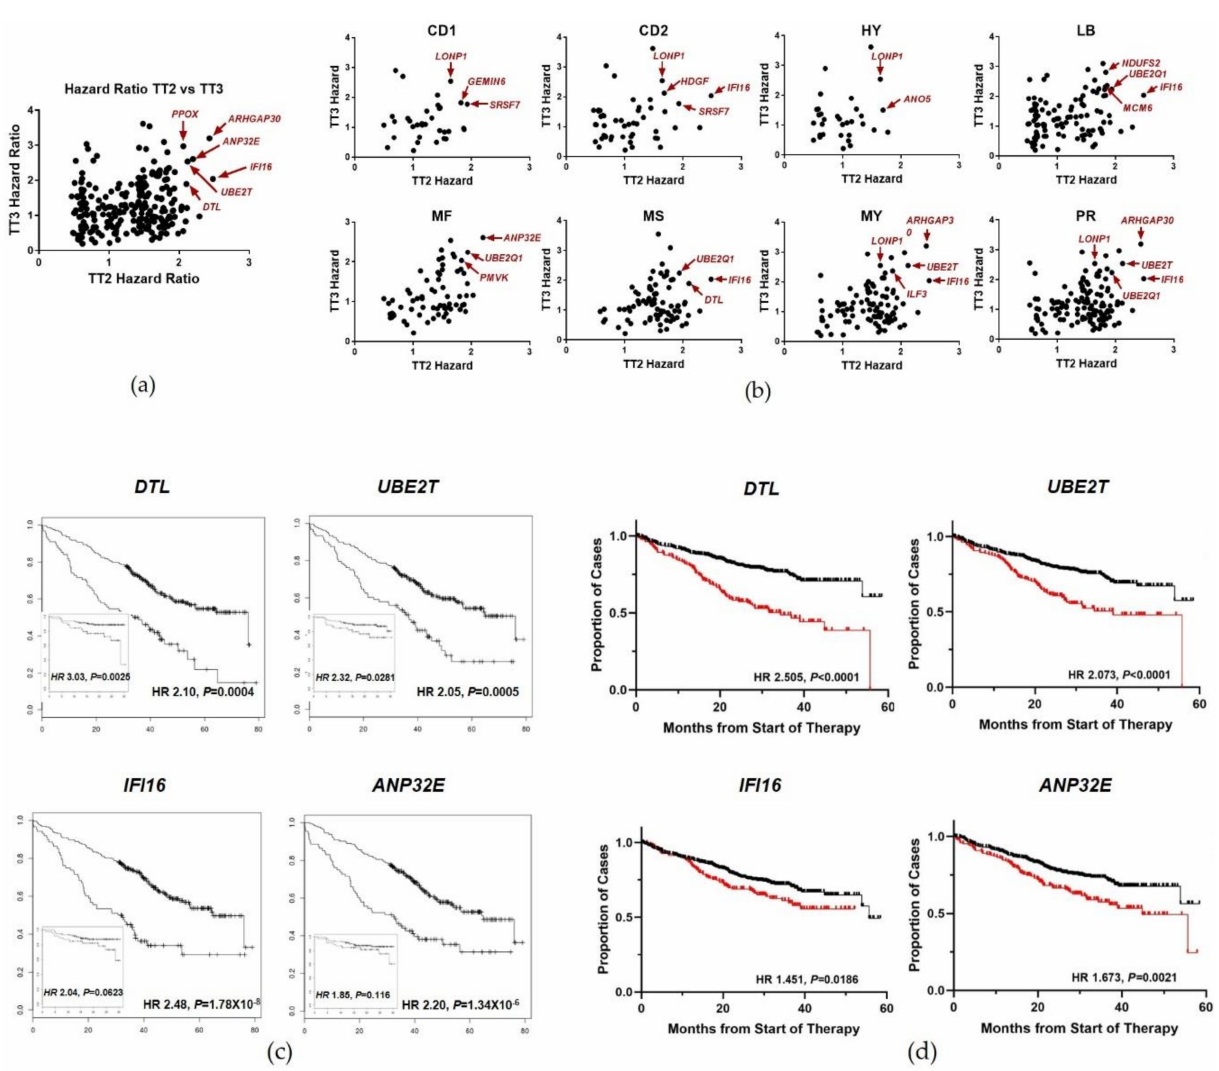
Figure 5. Independent Patient Samples Recapitulate the Results Observed in the Myeloma Expression Model. Hazard and Kaplan-Meier analysis was performed for significantly enriched genes within the TT2 and TT3 cohorts. ( a ) Hazard analysis comparing the complete TT2 and TT3 cohorts. ( b ) Hazard analysis comparing TT2 and TT3 from the individual myeloma subgroups. ( c ) Kaplan-Meier survival analysis for TT2 and TT3 cohorts highlighting select genes identified in the Hazard analysis. Kaplan-Meier and Hazard analysis were performed using the R project 2.14.2. Significance was determined as p < 0.05 with an FDR < 0.05 as determined by a student’s t -test. ( d ) Kaplan-Meier survival analysis of select genes in CoMMpass